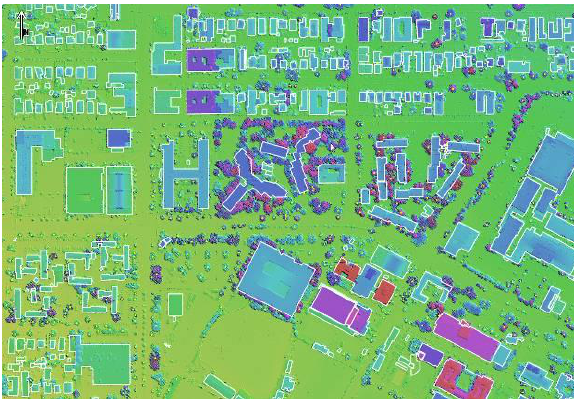
Figure 10. Trees are difficult to separate from buildings